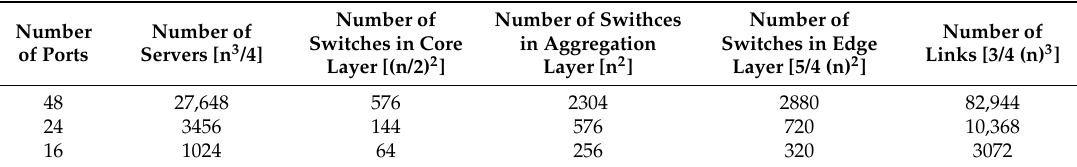
Table 1. Number of servers, switches and links in DCN fat-tree topology.